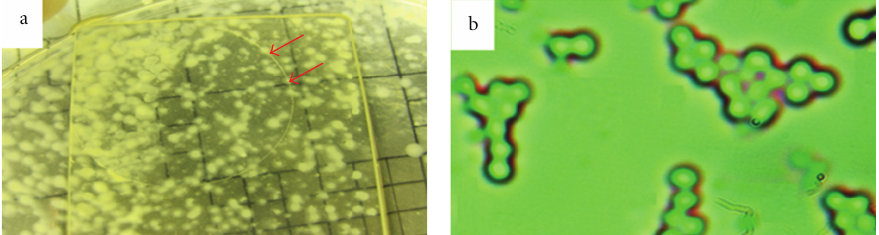
Figure 3: Direct visualisation of bacterial autoaggregation in liquid culture media of strongly, moderately, and weakly adherent isolates on a glass coverslip surface after a 48h incubation using a colony counter lens (a) and the Nikon Eclipse light microscope (b).